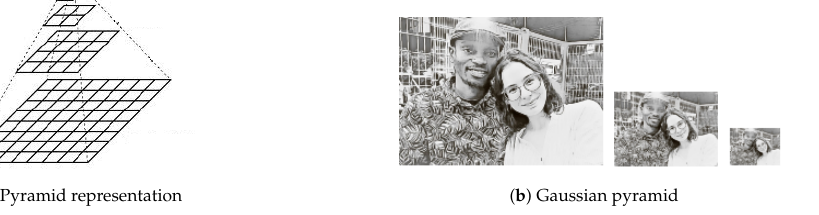
Figure 1. An example of Gaussian pyramids from the same input image. ( b ) First three levels of the Gaussian